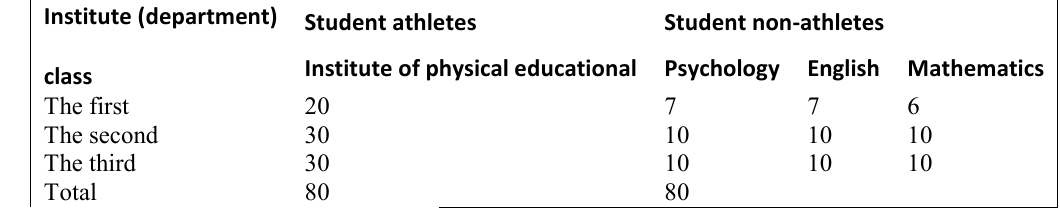
Figure.1. Distribution the members of sample Tool